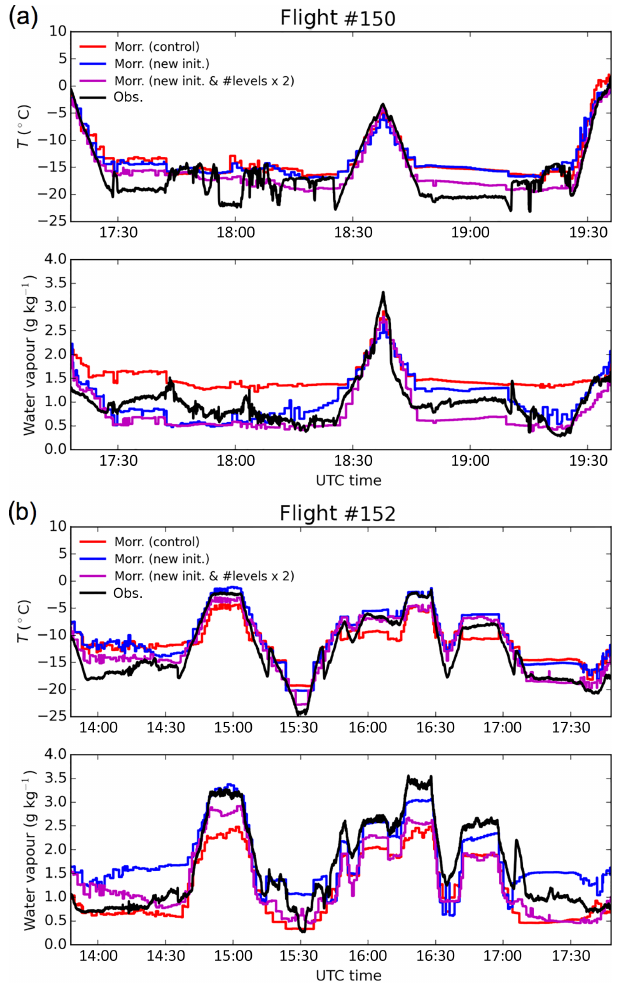
Figure 15. Time series of water vapour (gkg − 1 ) and temperature ( ◦ C) measured during (a) flight 150 and (b) flight 152. For pan- els (a) and (b) , the observation is the black solid line. Simulation outputs are overplotted: the simulations used to derive the averages presented in this work (red line), a different simulation over the pe- riod 11–20 January 2011 (thus with an initialization closer to the date of the measurements)(blue solid line), and the latter simulation with – additionally – a doubling of the number of vertical levels (60 instead of 30) (magenta solid